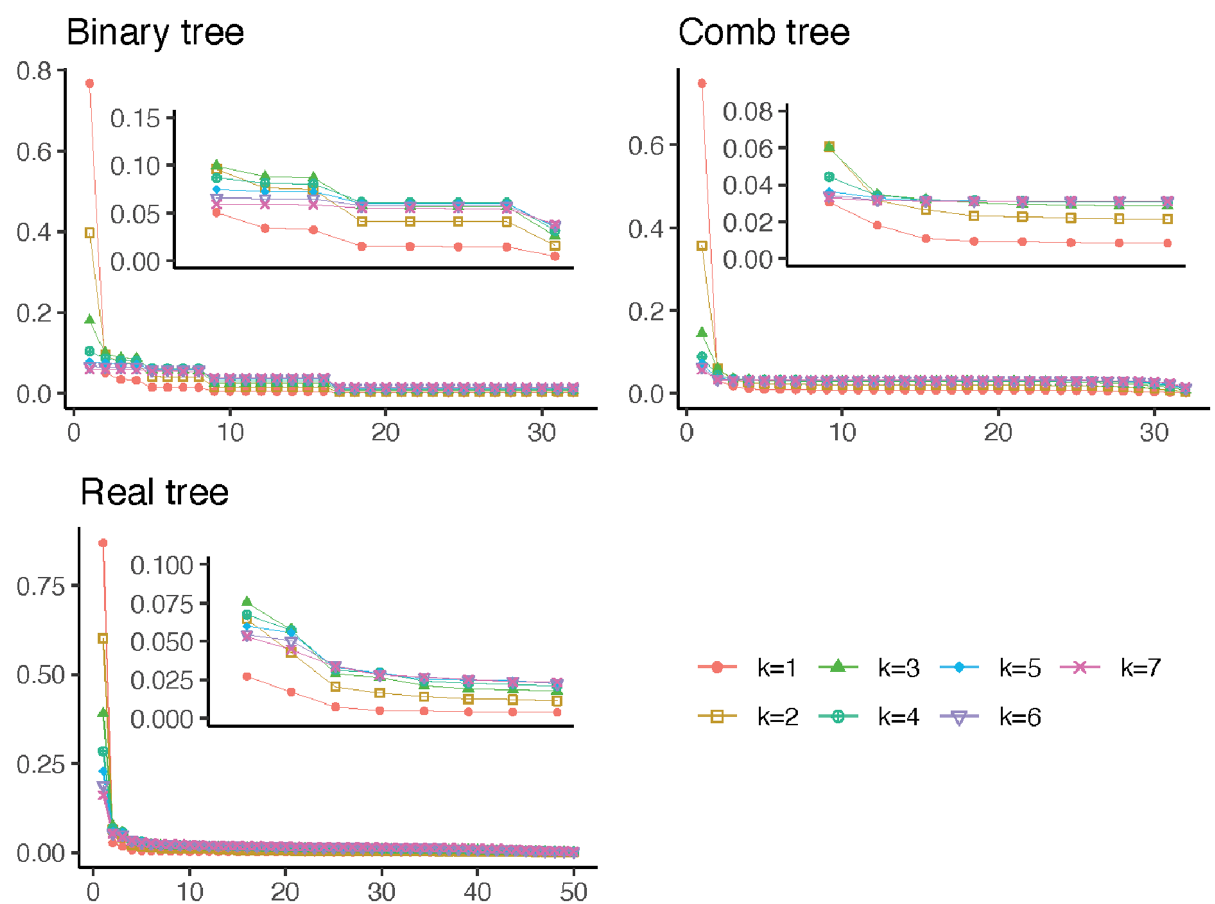
Fig 5. Eigenvalues for the matrix E (MM T ) for the balanced binary tree, the comb tree, and the real data tree. The inset plots are the same as the main plots, but with the horizontal axis truncated to remove the first